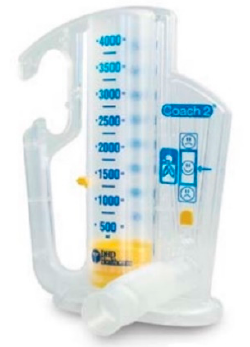
Figure 2. Incentive spirometry device, which provides visual cues to the patients that the desired flow or volume has been achieved.